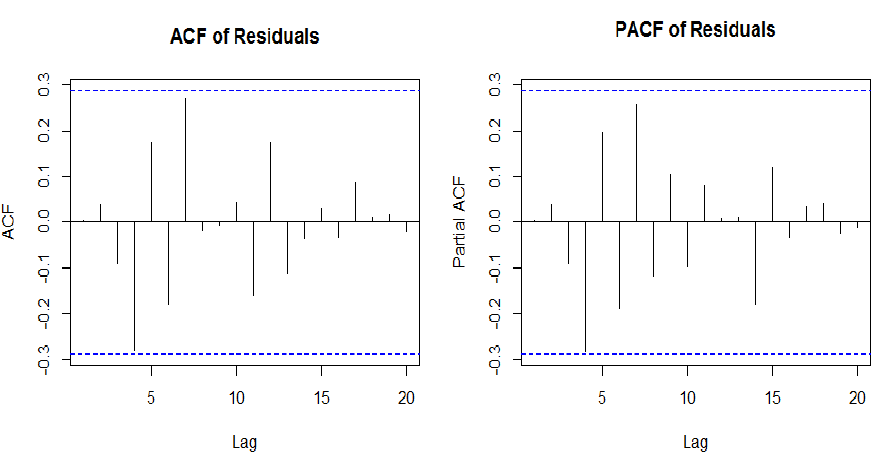
Figure 4. Residual error by autocorrelation function (ACF) and partial autocorrelation function (PACF) for ARIMA(1,1,1).